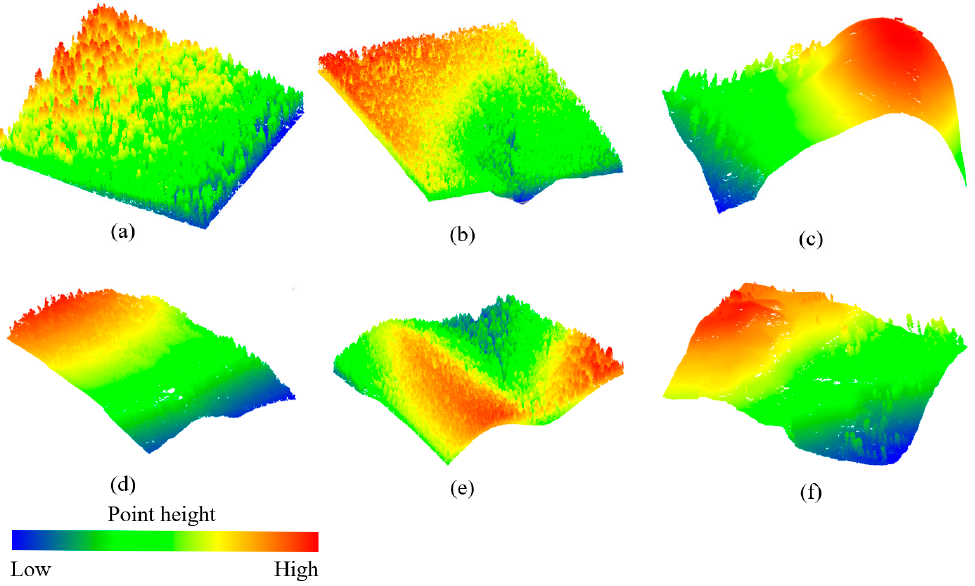
Figure 2. LiDAR point clouds of six forested sites: ( a – f ) Sites 1–6. Table 1. LiDAR data collection information for the six forested sites. The statistics of terrain and vegetation conditions for six forested sites are shown in Figure 3. They were calculated based on reference ground and non-ground points, which were generated through human–computer interaction. The slope of local terrain in each plot was obtained by calculating the angles between horizontal planes and the local terrain surfaces that were constructed by fitting planes based on the neighbor ground points of each ground point. The 10 m pixel-level canopy cover was calculated based on canopy height models (CHMs). The 1 m resolution CHMs were generated from LiDAR point